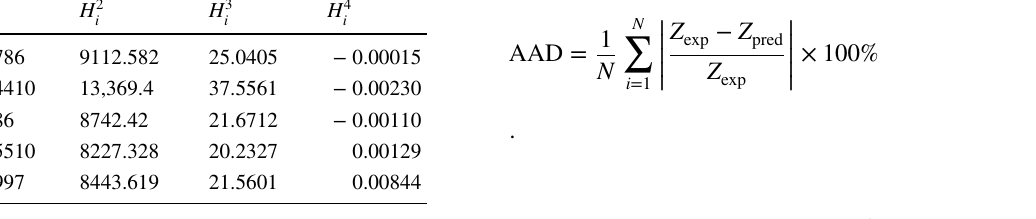
Table 5 The values of H i constants for the different guests Guest H 1